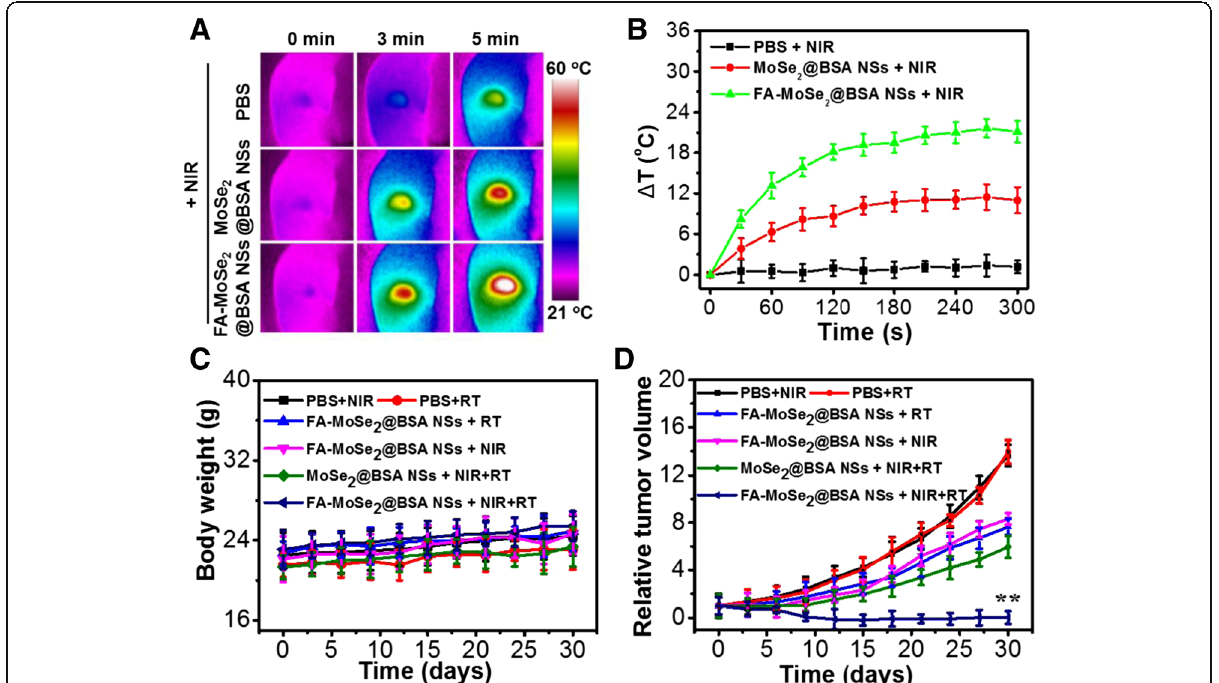
Fig. 8 a In vivo thermal images of mouse after intravenous injection of saline, MoSe 2 @BSA NSs and FA-MoSe 2 @BSA NSs and durations NIR irradiation (808 nm, 1 W/cm 2 ). b The corresponding temperature change curves of tumor regions in mice. c The weight and d relative tumor volume profile of 4T1 xenografted tumors after intravenous injection of PBS + RT, PBS + NIR, FA-MoSe 2 @BSA NSs + NIR, FA-MoSe 2 @BSA NSs + RT,